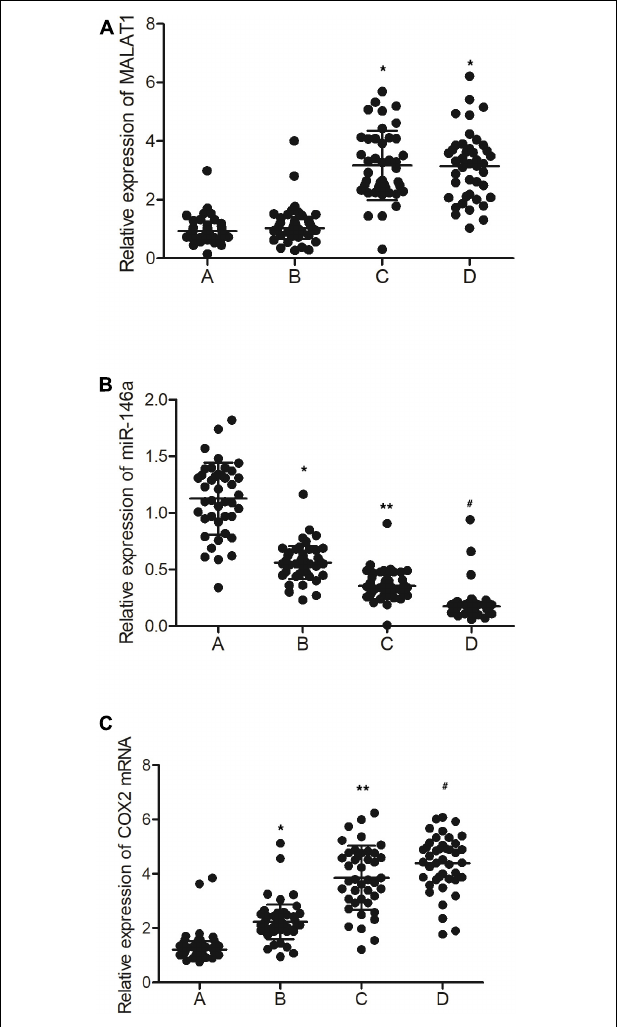
FIGURE 2 | The levels of MALAT1, miR-146a, and COX2 mRNA in PBMC samples were different among different groups (A: MALAT1 HYPER + miR-146a HYPO group; B: MALAT1 HYPER + miR-146a HYPER group; C: MALAT1 HYPO + miR-146a HYPO group; D: MALAT1 HYPO + miR-146a HYPER group. * p < 0.05 vs. group A; ** p < 0.05 vs. group B; # p < 0.05 vs. group C). (A) Relative expression of MALAT1 in the PBMC samples was similar between MALAT1 the HYPER + miR-146a HYPO group and the MALAT1 HYPER + miR-146a HYPER group, while being lower than that of the MALAT1 HYPO + miR-146a HYPO group and the MALAT1 HYPO + miR-146a HYPER group. (B) Relative expression of miR-146a in the PBMC samples gradually decreased following the order of MALAT1 HYPER + miR-146a HYPO group, MALAT1 HYPER + miR-146a HYPER group, MALAT1 HYPO + miR-146a HYPO group, and MALAT1 HYPO + miR-146a HYPER group. (C) Relative expression of COX2 mRNA in the PBMC samples gradually increased following the order of MALAT1 HYPER + miR-146a HYPO group, MALAT1 HYPER + miR-146a HYPER group, MALAT1 HYPO